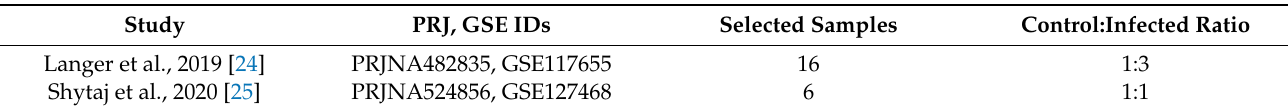
Table 1. Summary of studies included in the meta-analysis of gene expression profiles of CD4+ T infected with HIV-1 in vitro.